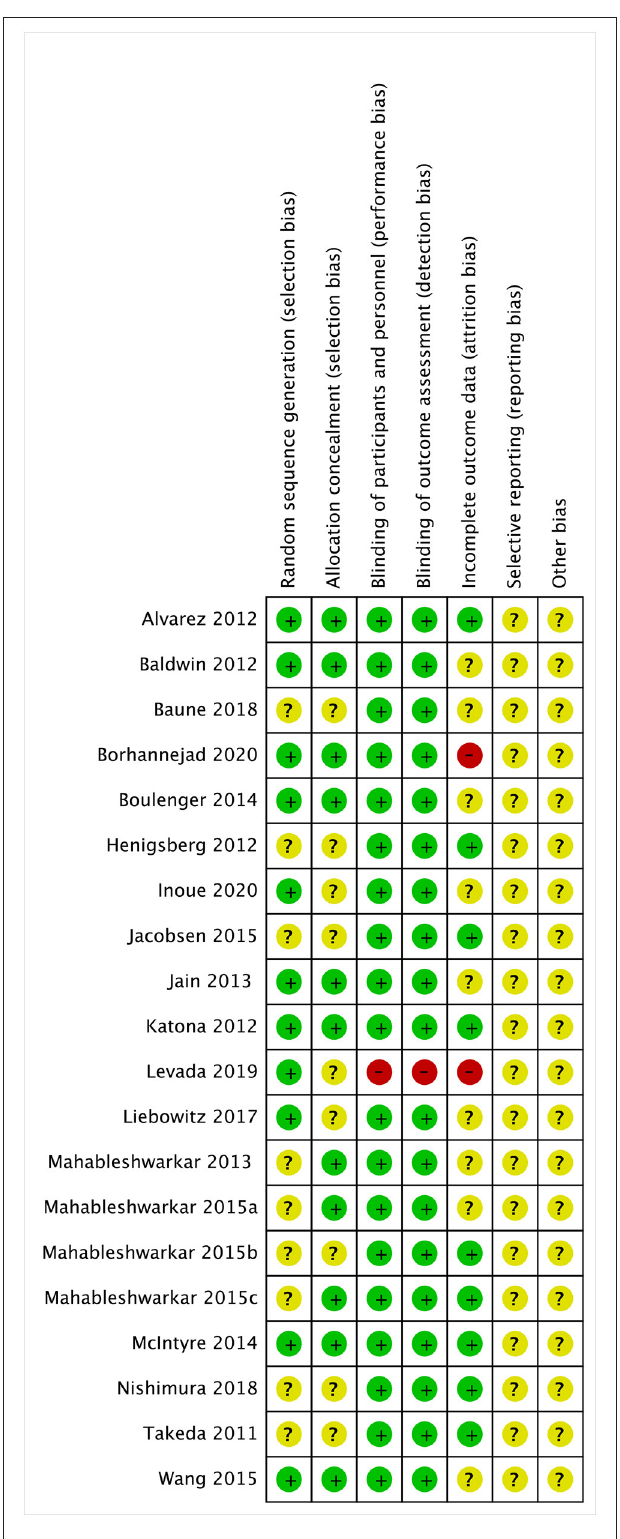
FIGURE 3 | Risk of bias